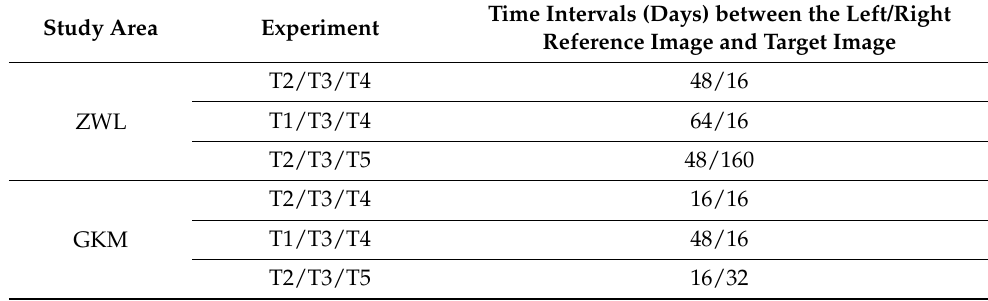
Table 2. Comparison experiments carried out in the ZWL and GKM with different time intervals. Study